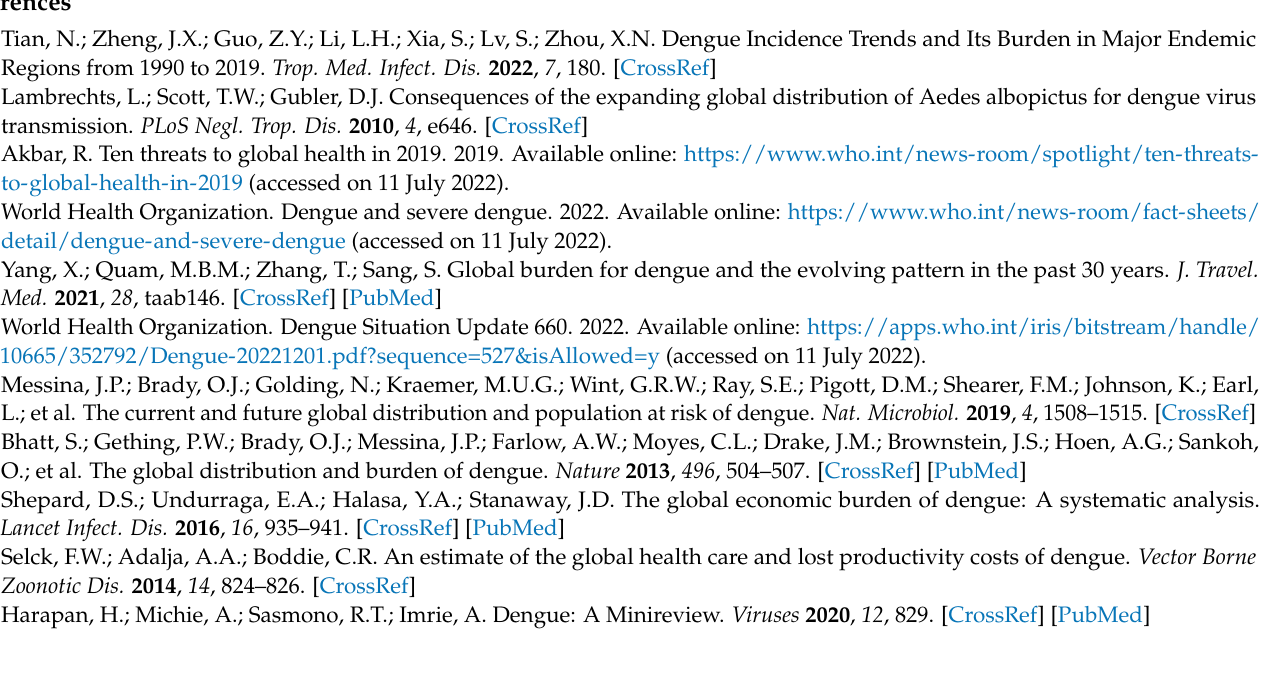
Supplementary Table S9: Trusted stakeholders for health-related information. A copy of the entire questionnaire is available as Supplementary File